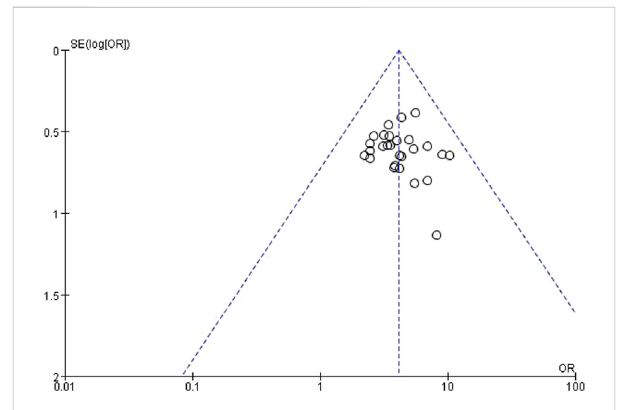
FIGURE 8 The total ef fi ciency of the funnel plot analysis on Rhubarb herbal retention enema treatment of